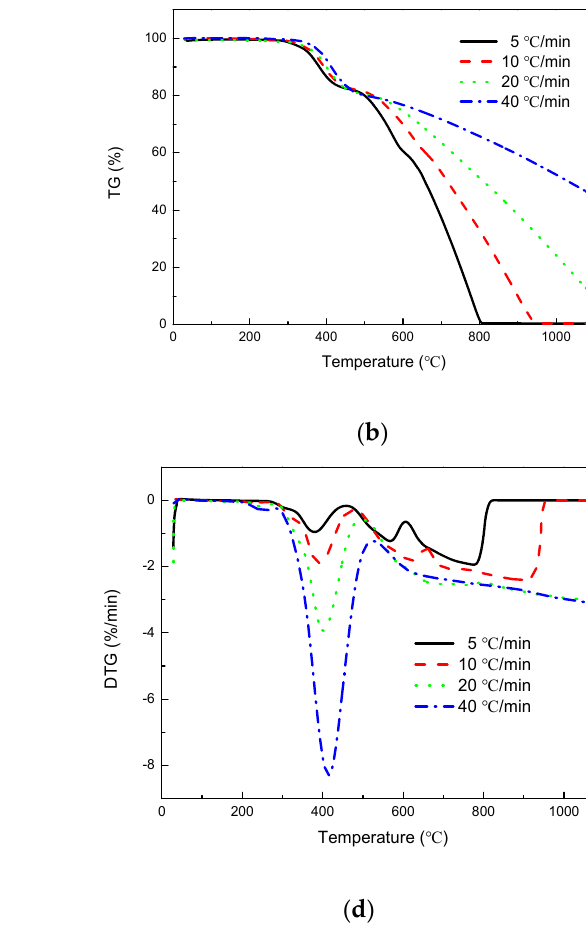
Figure 3. ( a ) TG curves and ( c ) DTG curves under inert atmosphere; ( b ) TG curves and ( d ) DTG curves under air atmosphere for T300/Epoxy composites at 5, 10, 20 and 40 °C/min.